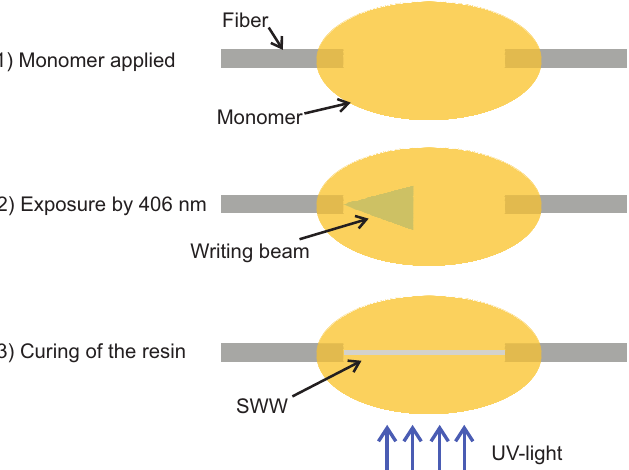
Figure 1. Scheme of the writing process of an SWW created between two silica fibers. As indicated in Figure 1, a monomer drop is applied between two silica fibers which are aligned with respect to one another along their common optical axis. One of the fibers, which is connected to a laser diode, emits light at λ = 406 nm, which starts the polymerization process at the end of the fiber. This process step is illustrated in Figure